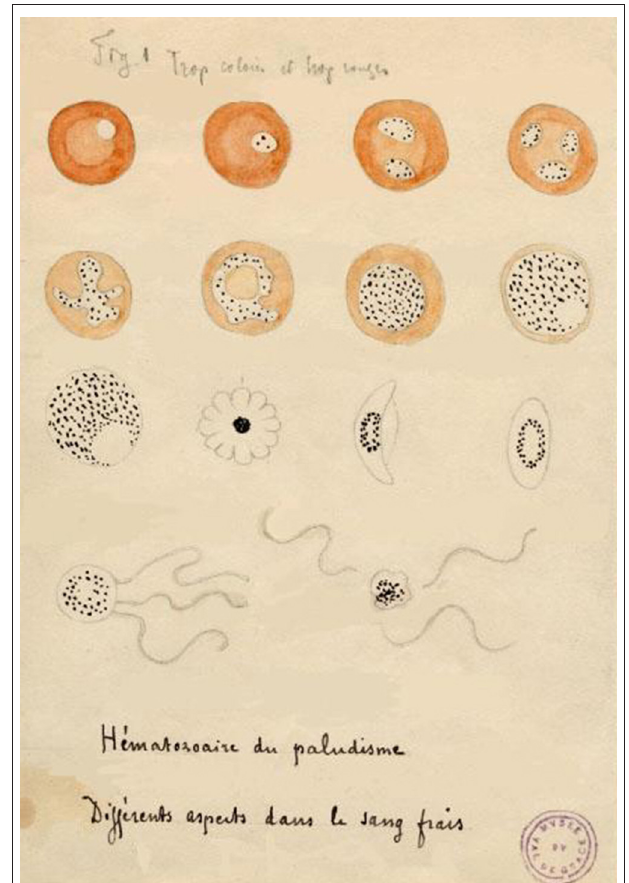
FIGURE 1 | Drawing by Alphonse Laveran of the different aspects of hematozoan malaria’